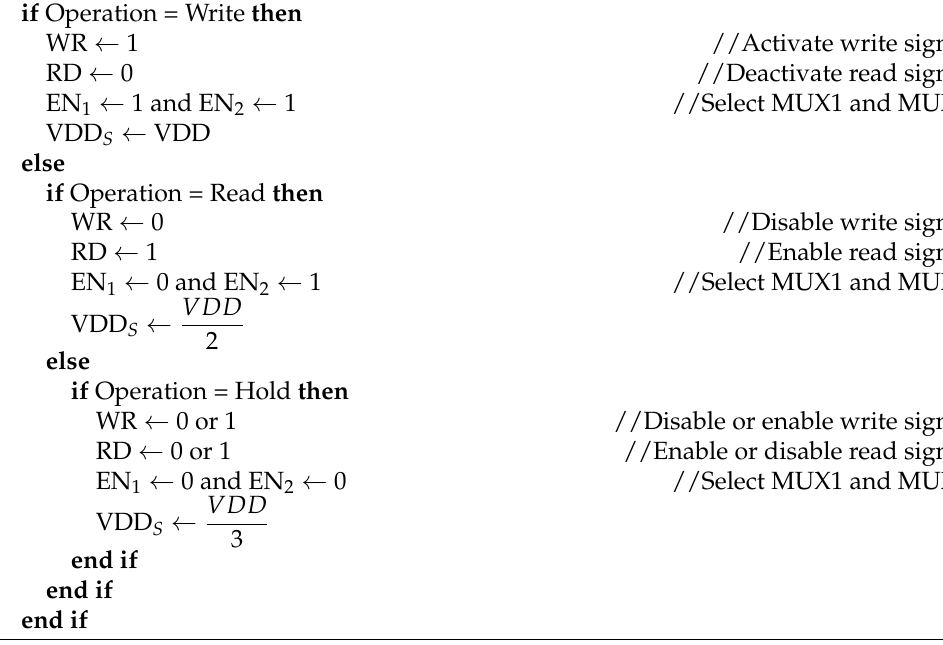
Algorithm 1 Voltage controller (VC) and decision circuit (DC) operation in SRAM cells